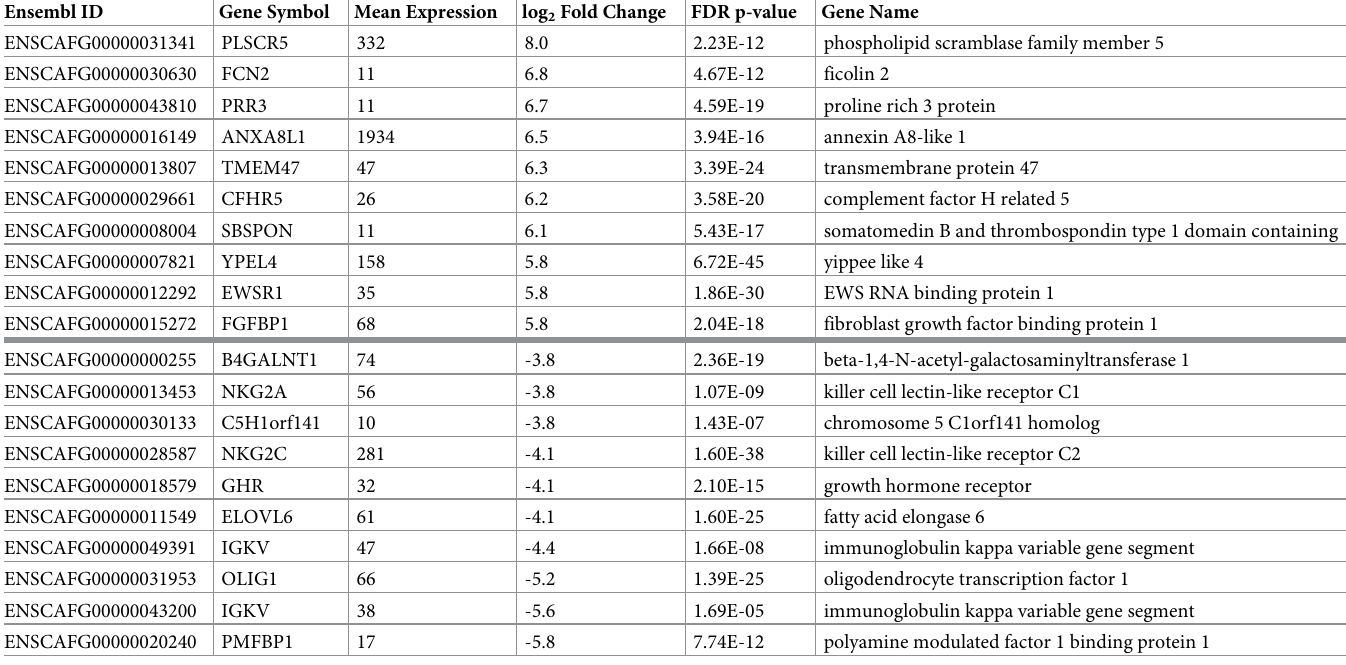
Table 2. Top 10 over- and underexpressed genes in dogs with IMHA vs. healthy dogs. Ensembl ID Gene Symbol Mean Expression log 2 Fold Change FDR p-value Gene Name